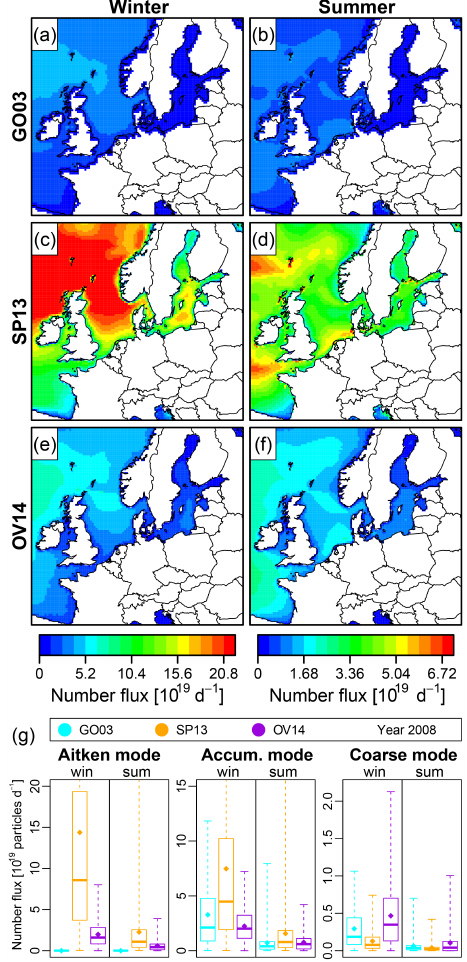
Figure 9. Similar to Fig. 7 but showing sea salt number